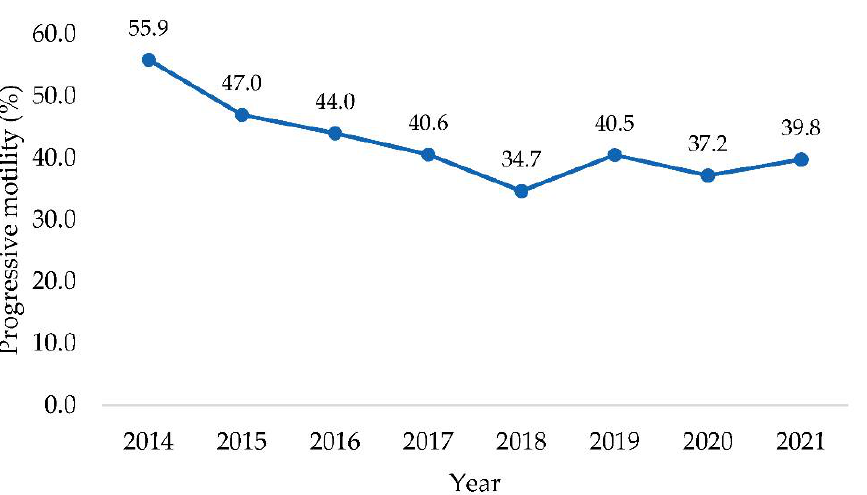
Figure 2. The trend of progressive motility of 577 Italian Simmental young bulls recorded in the time interval comprised from 2014 to 2021.